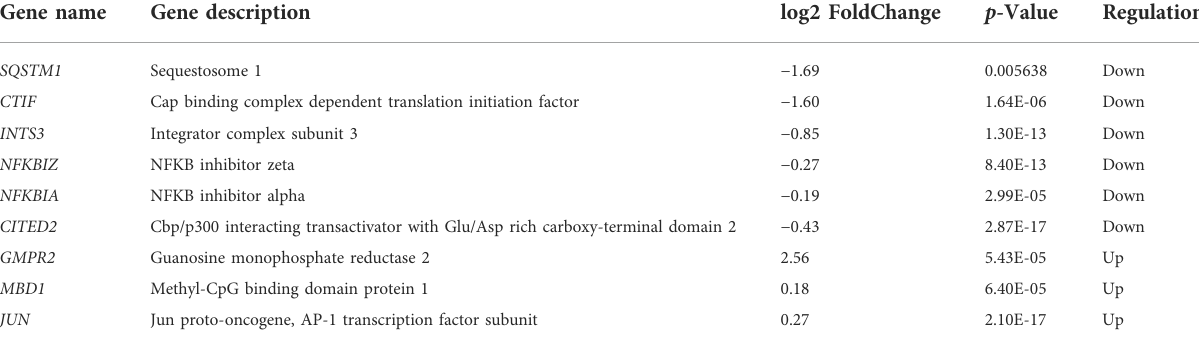
TABLE 4 Signi fi cantly upregulated or downregulated genes in HGG + OGD/R vs.